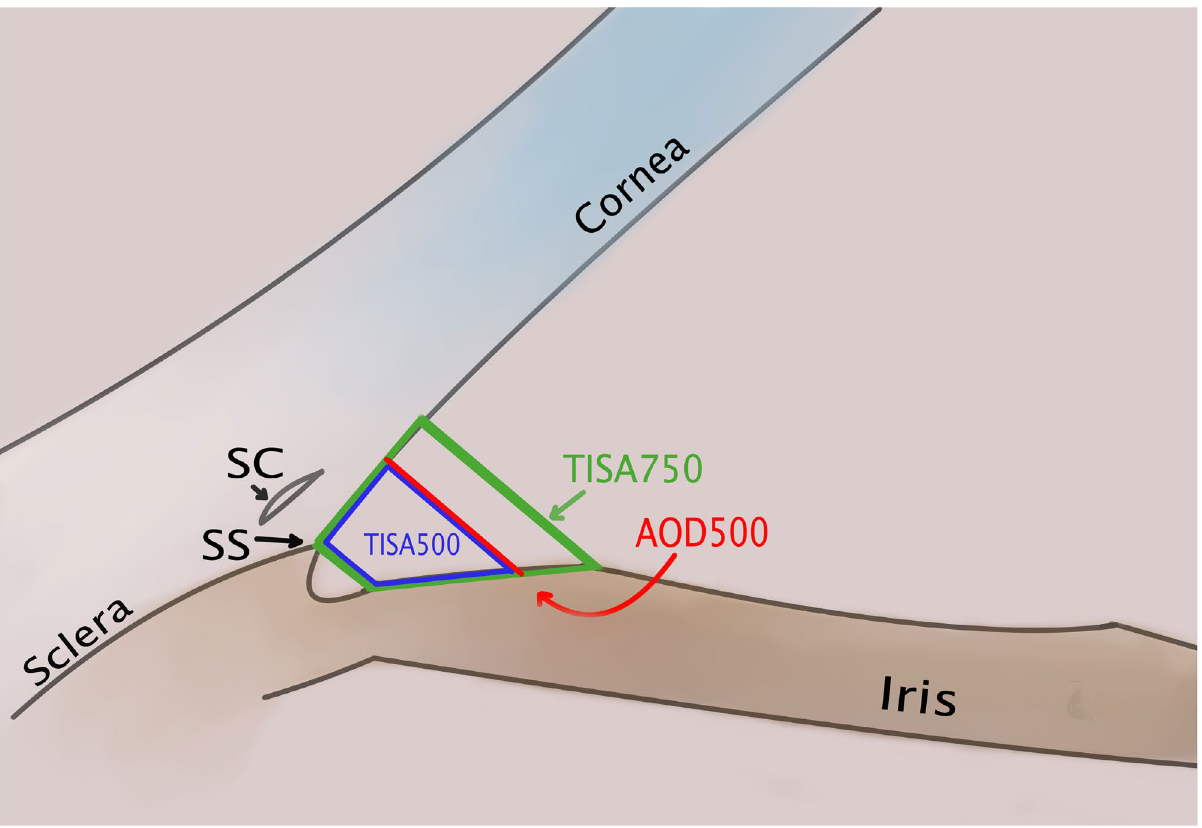
Figure 4. Measurements of anterior angle structures: AOD500, TISA500, TISA750. SS scleral spur, SC Schlemm’s canal. (Illustration made using Clip Studio Paint PRO Ver. 1.9.10 ©CELSYS Inc. https:// www. clips tudio. net/